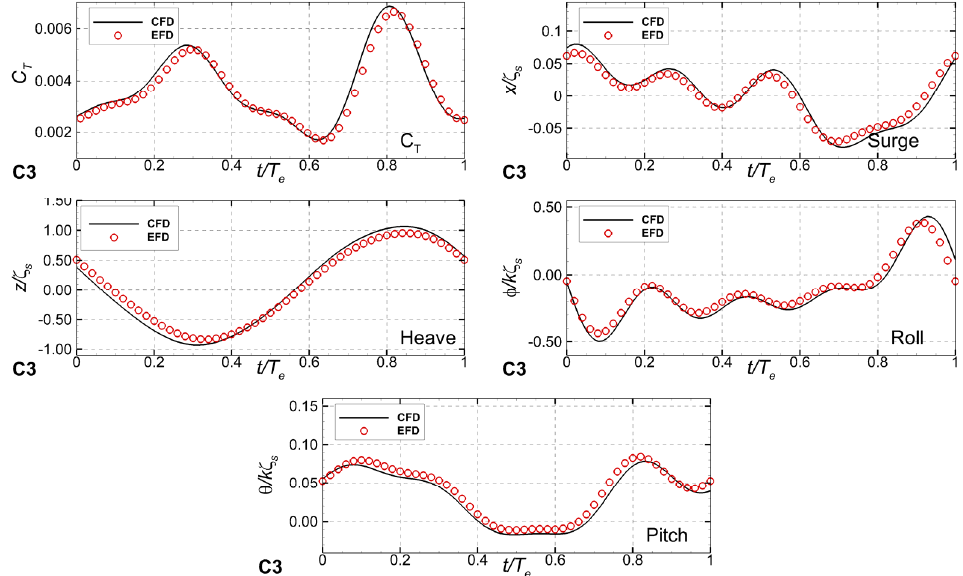
Figure 22. Comparisons between the time histories of the reconstructed resistance coefficient ( C T ) , surge ( x ) , heave ( z ) , roll ( ϕ ) , and pitch ( θ ) measured (EFD) [33], and computed (CFD) over a period of the encounter in the FRxz ϕθ beam waves scenario.